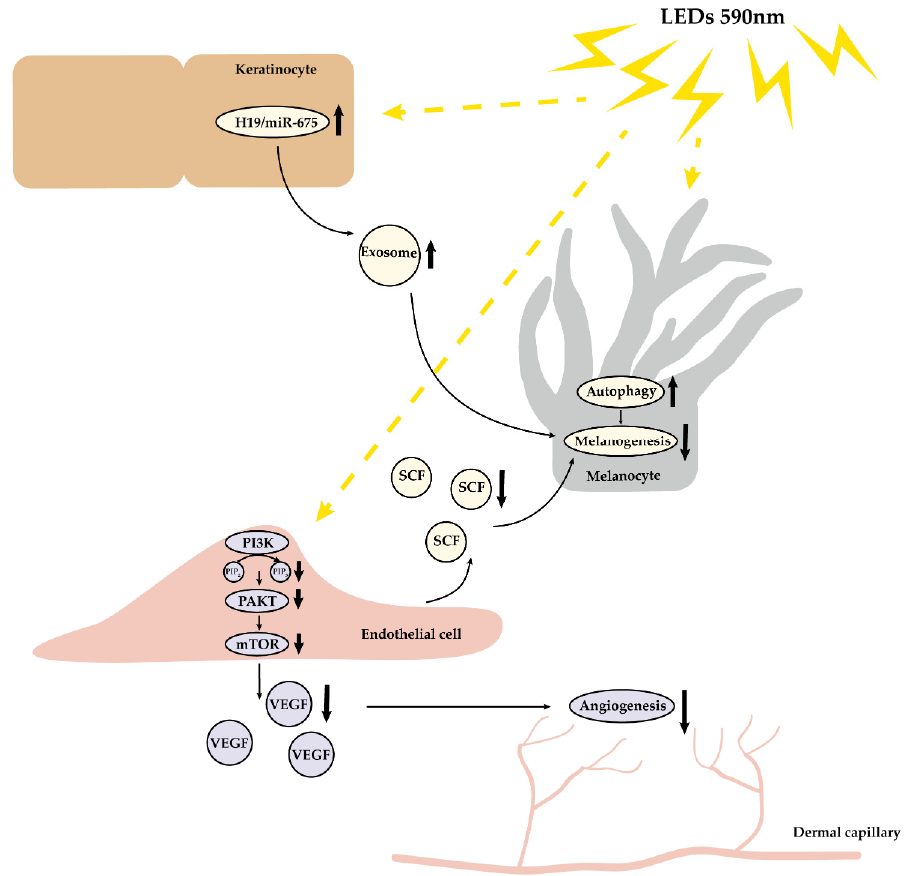
Figure 7. Multiple effects of 590 nm LED photobiomodulation on the microenvironment of skin. 590 nm LED alleviated angiogenesis through inhibiting cell migration, tube formation and VEGF release in endothelial cells, predominantly via the downregulation of the AKT/PI3K/mTOR pathway. In addition, LED suppressed melanogenesis via inducing autophagy in melanocytes, upregulating the H19/miR-675 axis and its exosome in keratinocytes, probably through decreasing the secretion of SCF in endothelial cells. LED, light-emitting diodes; VEGF, vascular endothelial growth factor; SCF, stem cell factor.